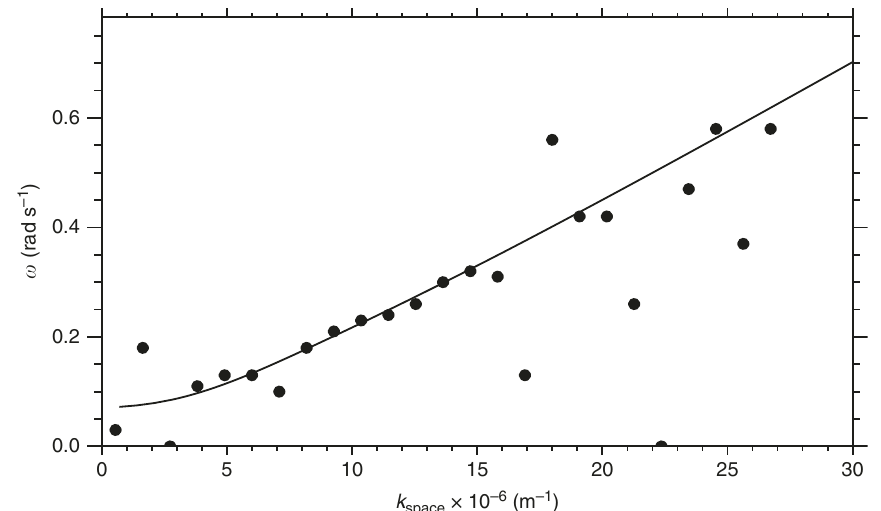
Fig. 9 Comparison of observed and theoretical dispersion relations. Results from the theoretical dispersion relation for a parallel wavelength of 1.8 R E are shown, together with the peaks for each wavenumber determined from the observational dispersion relation used to conduct the Chi-squared test